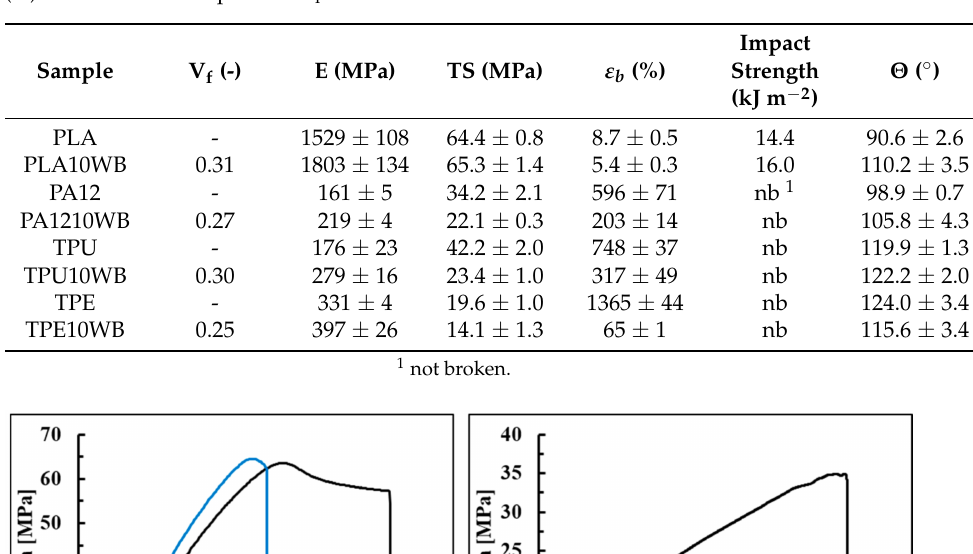
Table 4. Tensile properties (E, TS, and ε b ), Charpy impact properties, and water contact angle values ( Θ ) of WB-based composites. V f refers to the fiber volume fraction.